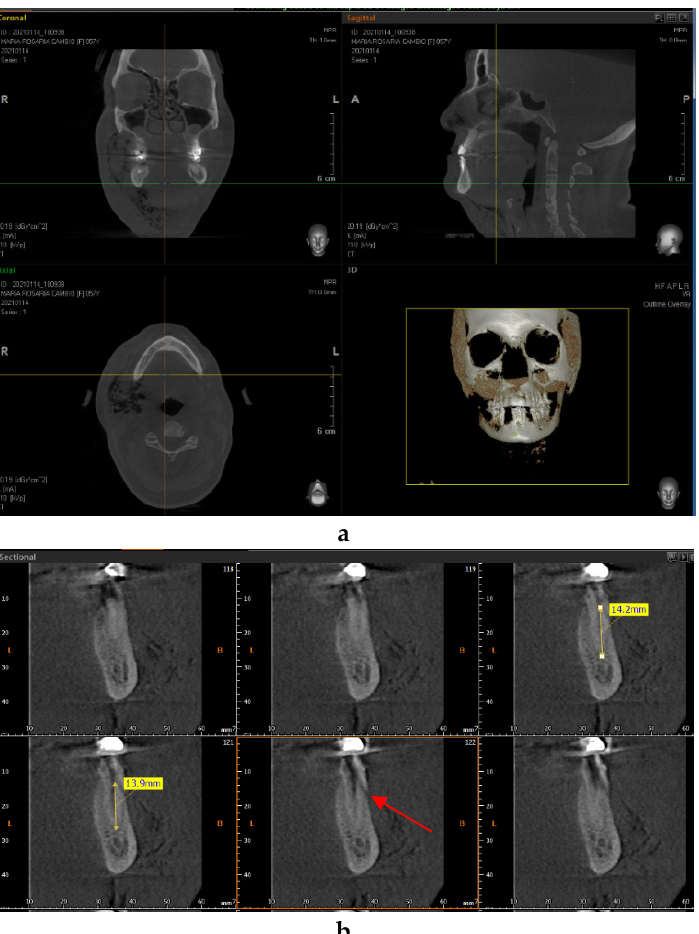
Figure 1. ( a , b ) Extraoral examination. An area of swelling on the right side of the cervicofacial region is clearly visible. ( c , d ) Intraoral examination. The right fornix and oral floor appear inflated.